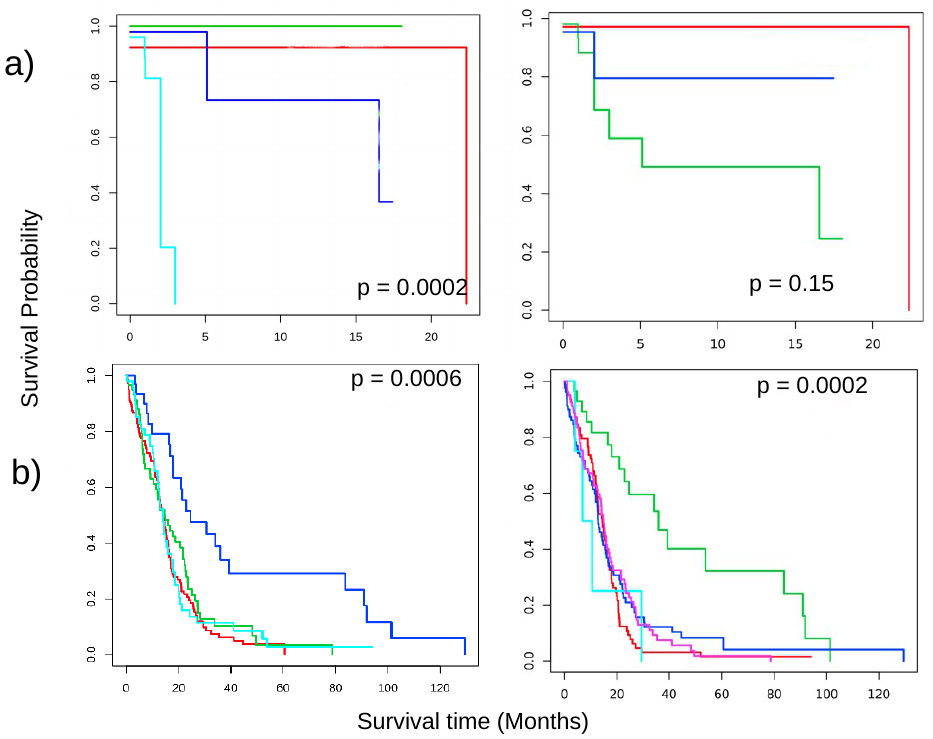
Figure 3. Disease subtype detection using DTA as a feature reduction step. Kaplan–Meier curve of the detected subtypes using DTA (left) and maximum variance (right) selected genes of ( a ) COAD cancer; and ( b ) GBM cancer. The colors indicate the different clusters that were identified. p -value signifies that the patients in different subtypes have different survival